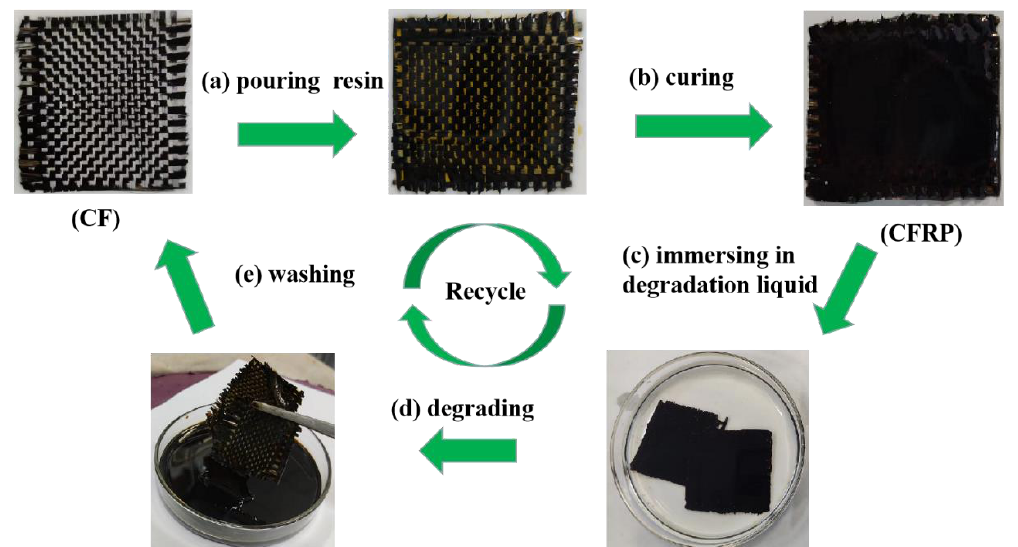
Figure 8. Recycling procedure of VAN-AC-EP-CF.